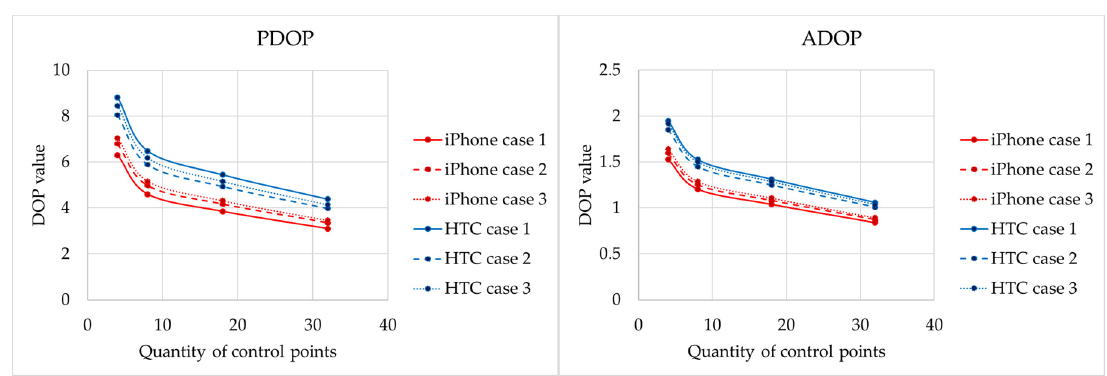
Figure 10. The DOP values of quantity analysis for two smartphones.